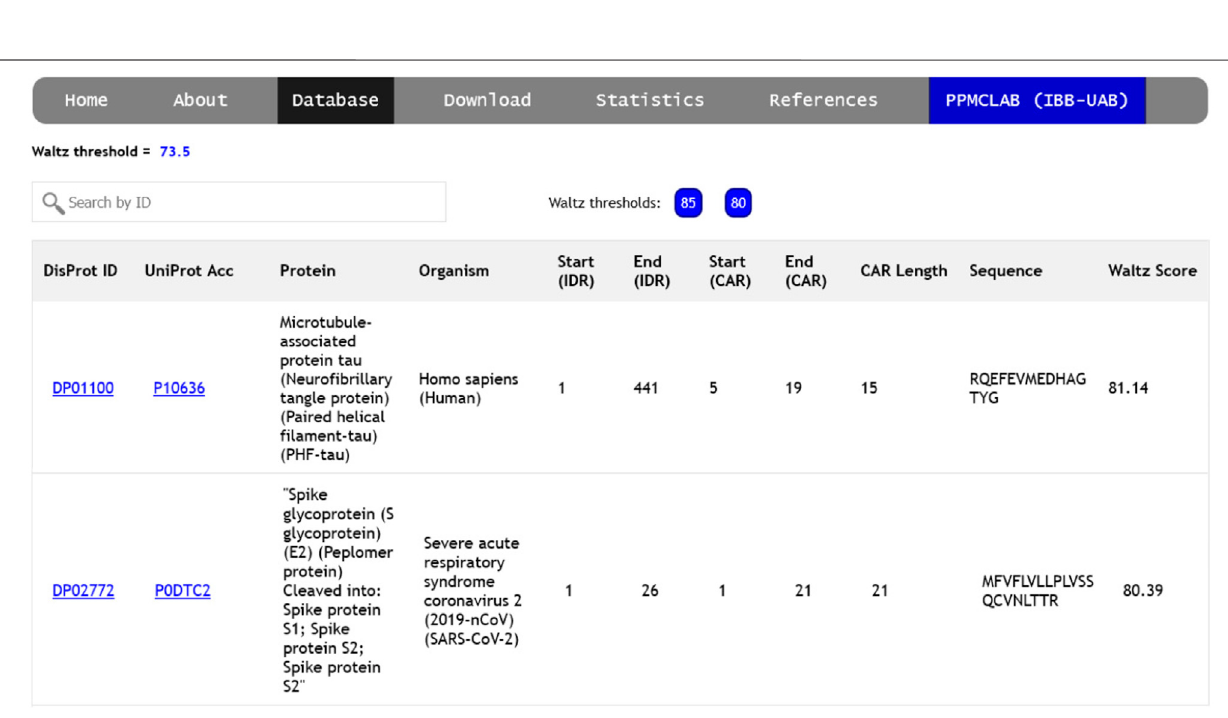
Frontiers in Molecular Biosciences |